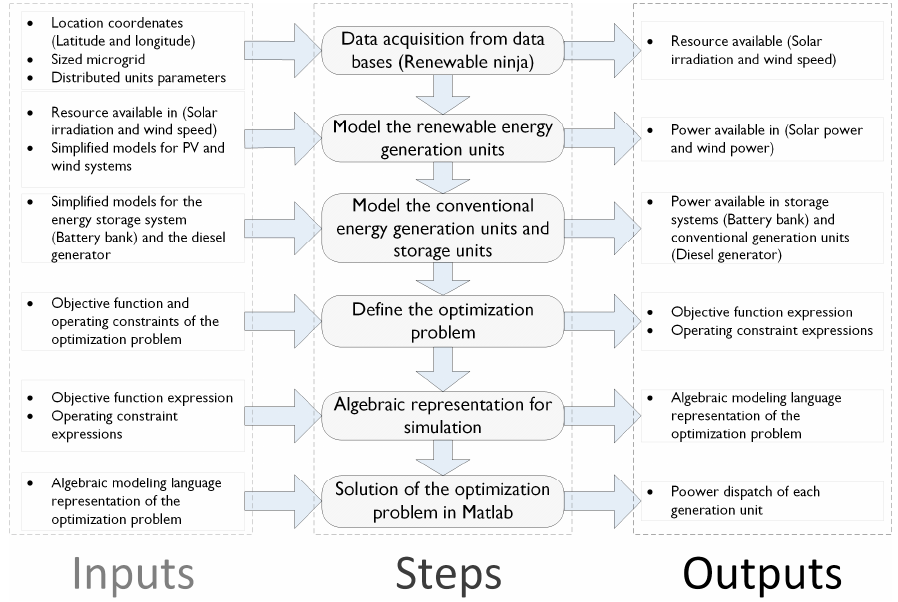
Figure 1. Flowchart of the design methodology.